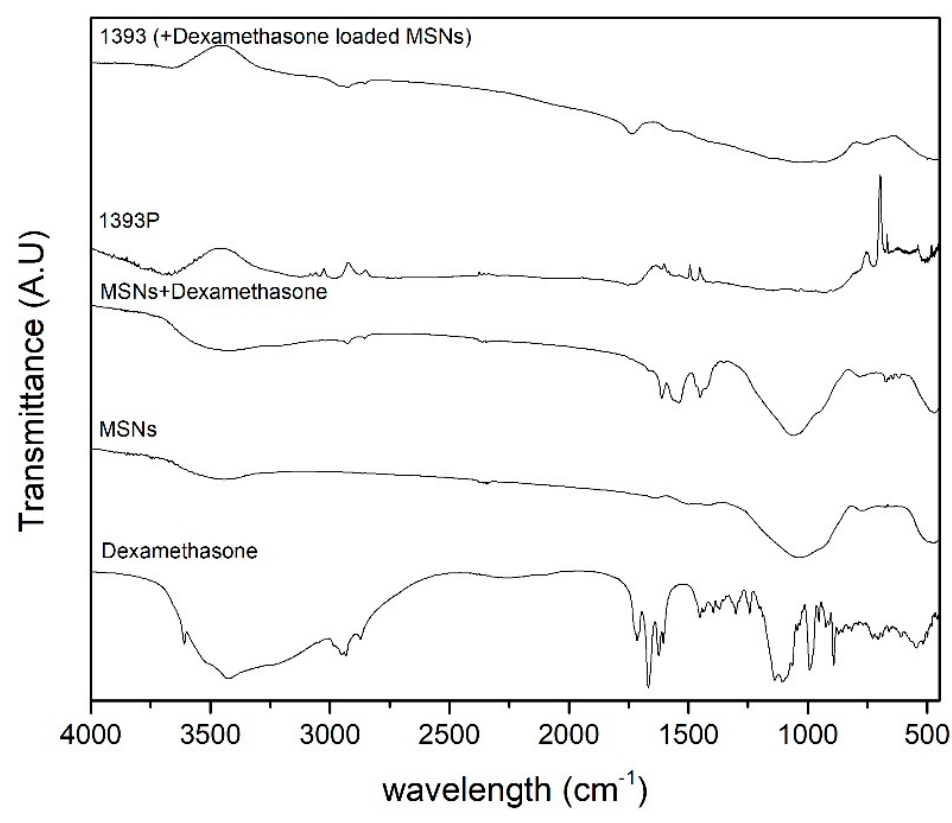
Figure 6. FTIR spectra of dexamethasone, MSNs, loaded MSNs, coated MSNs, and coated and drug-loaded samples.